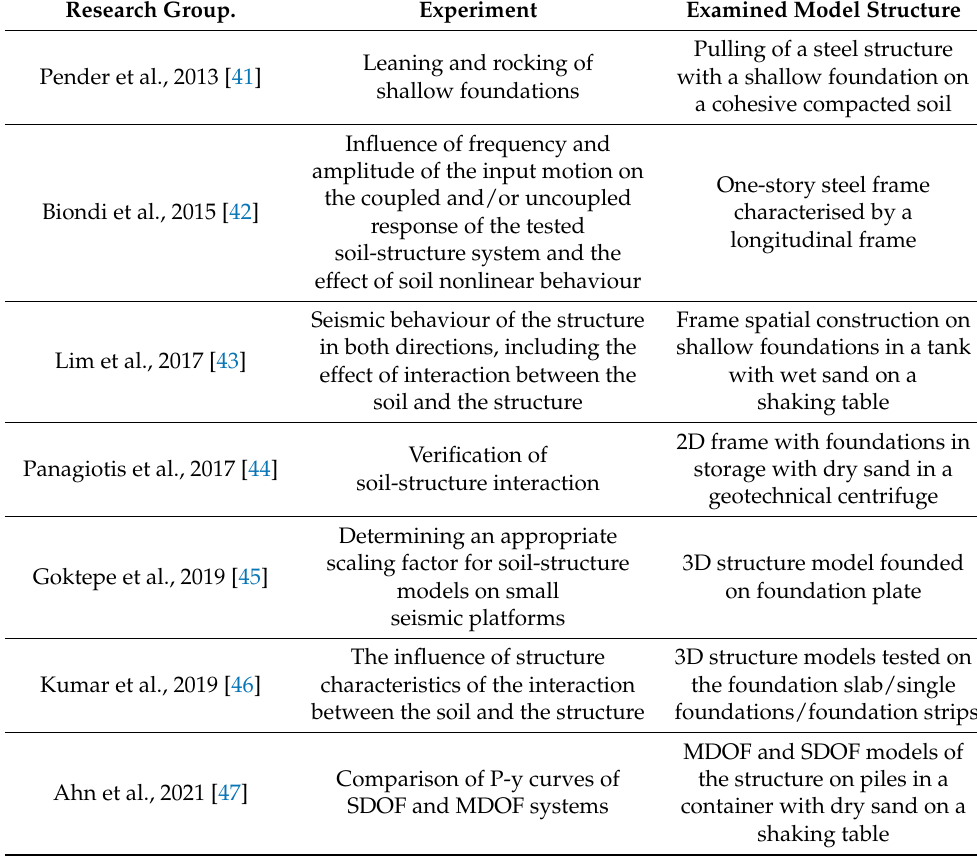
Table 1. An overview with a description of the experiments carried out with the aim of research in the field of interaction between soil and structures. Research